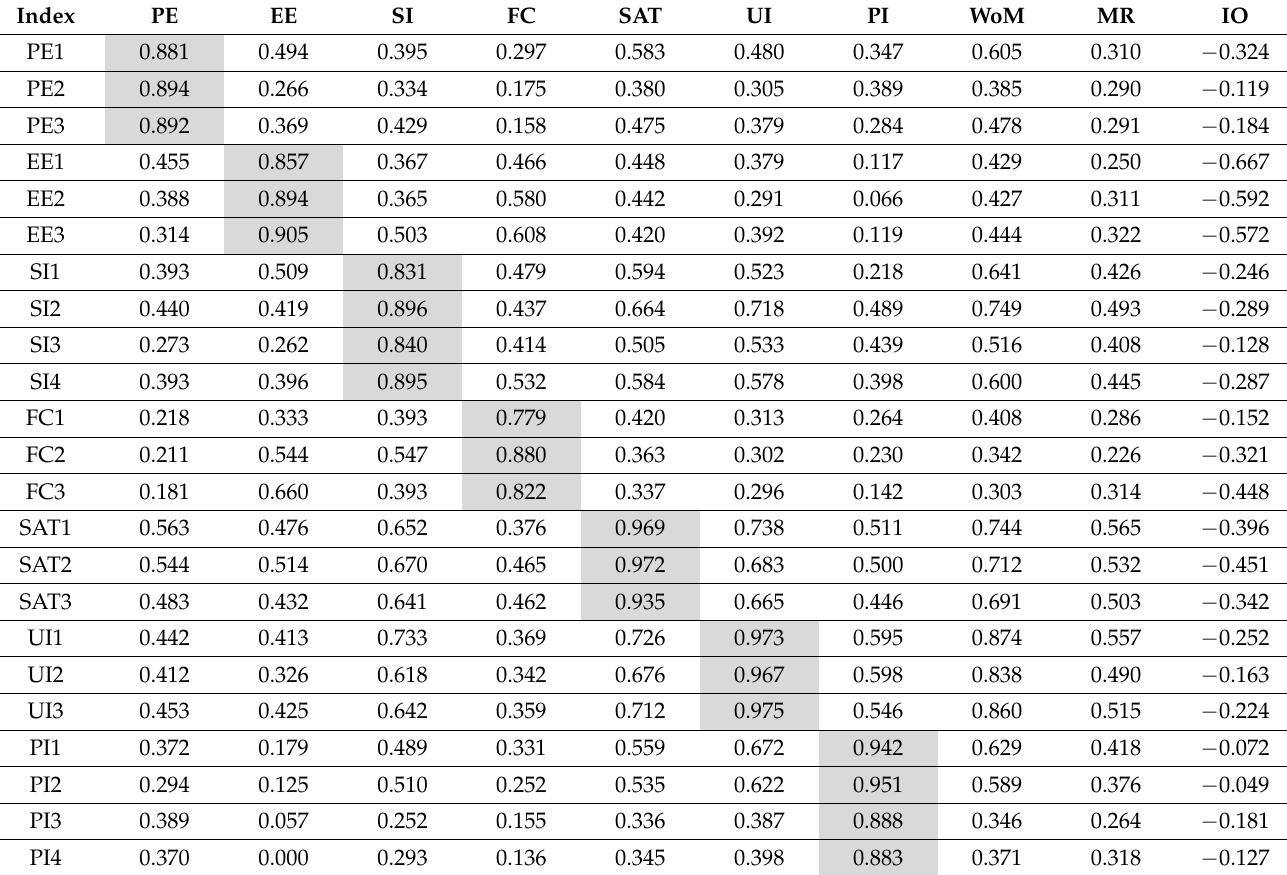
refer to Table 2. Table 5. Factor-loading